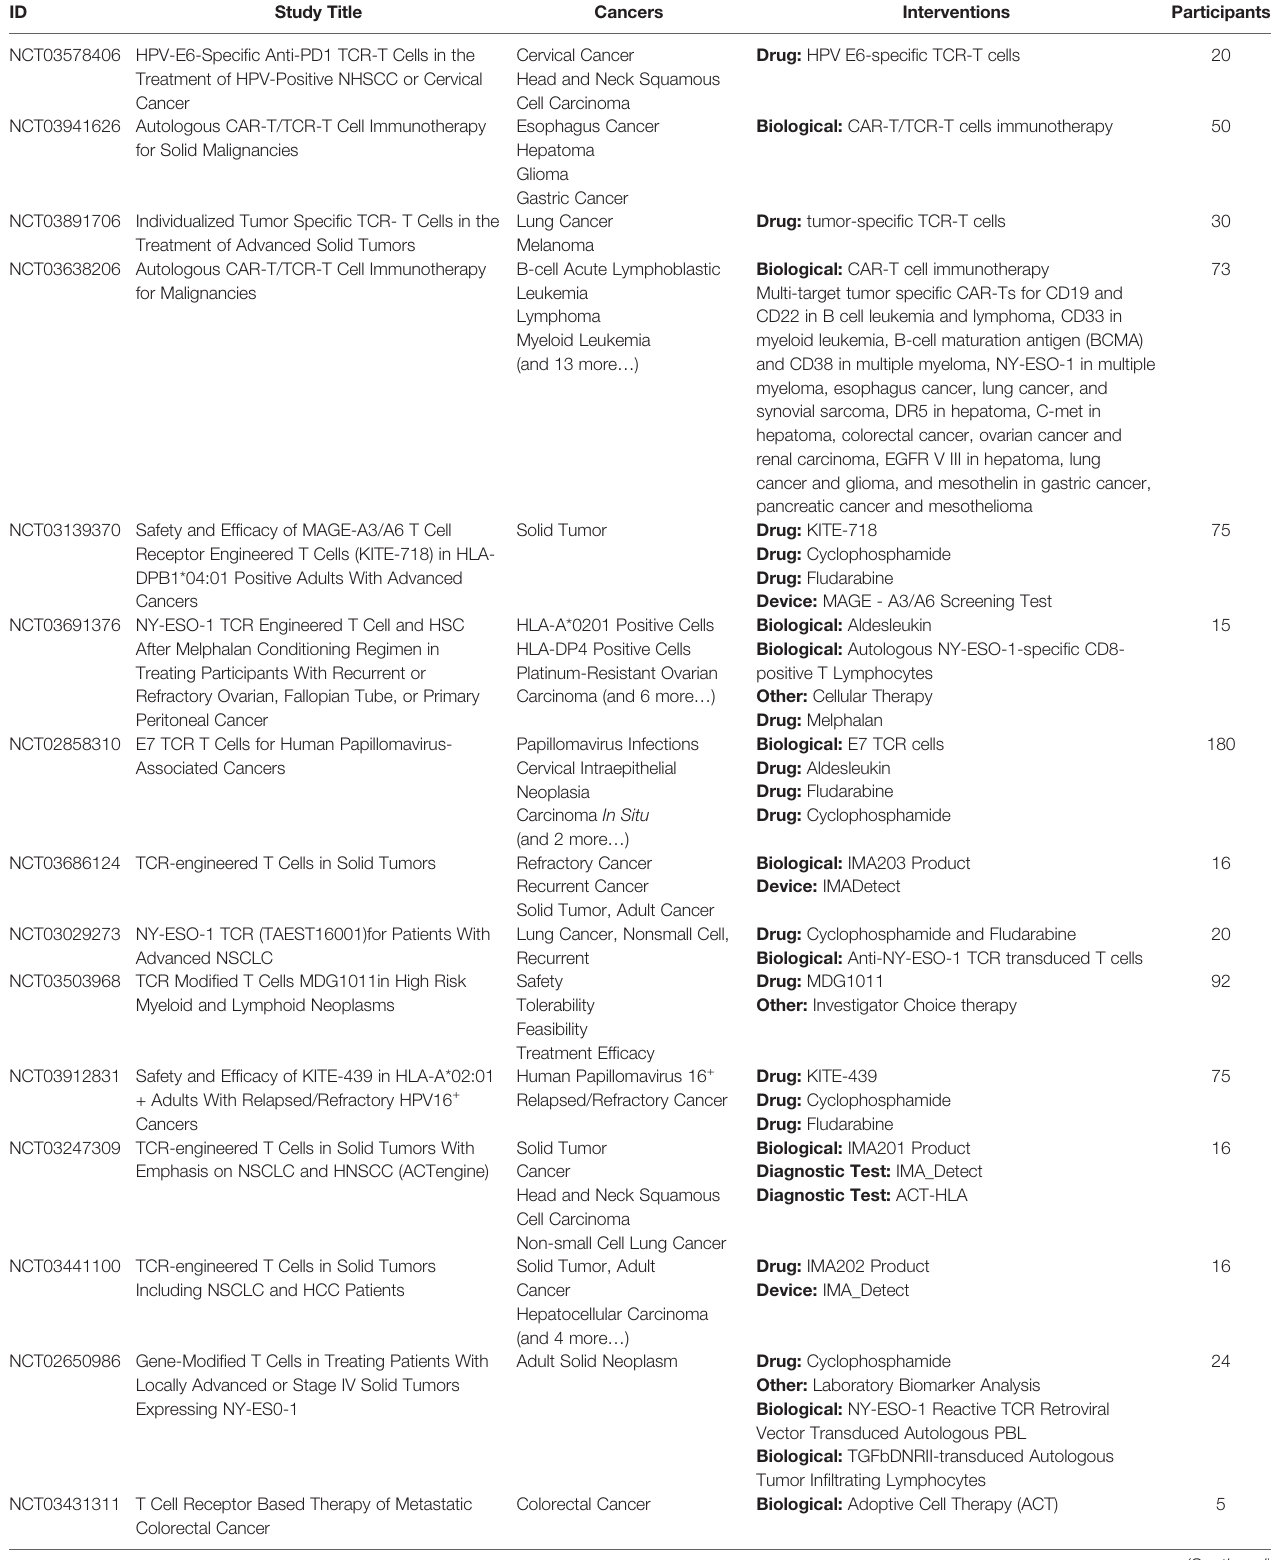
TABLE 2 | Clinical trials activated on engineered TCR-T